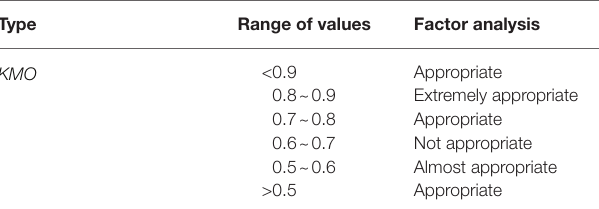
TABLE 1 | Measurement standard of